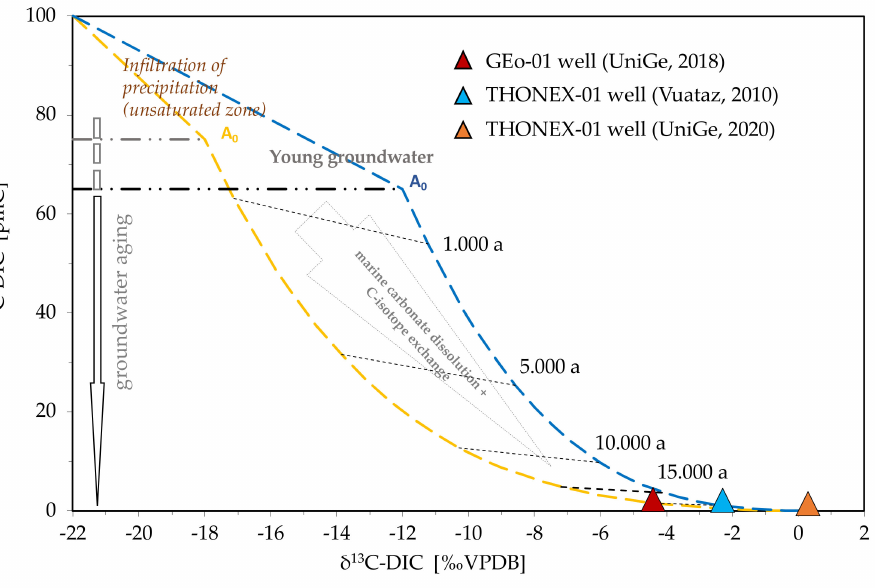
Figure 16. Carbon Isotopes distribution for the geothermal water samples at the two exploration wells in the Geneva